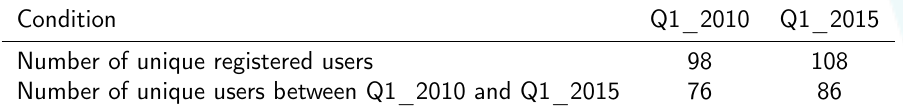
Table 8: OAEHSGCO and HSSU65PL agreements for difference postcodes in